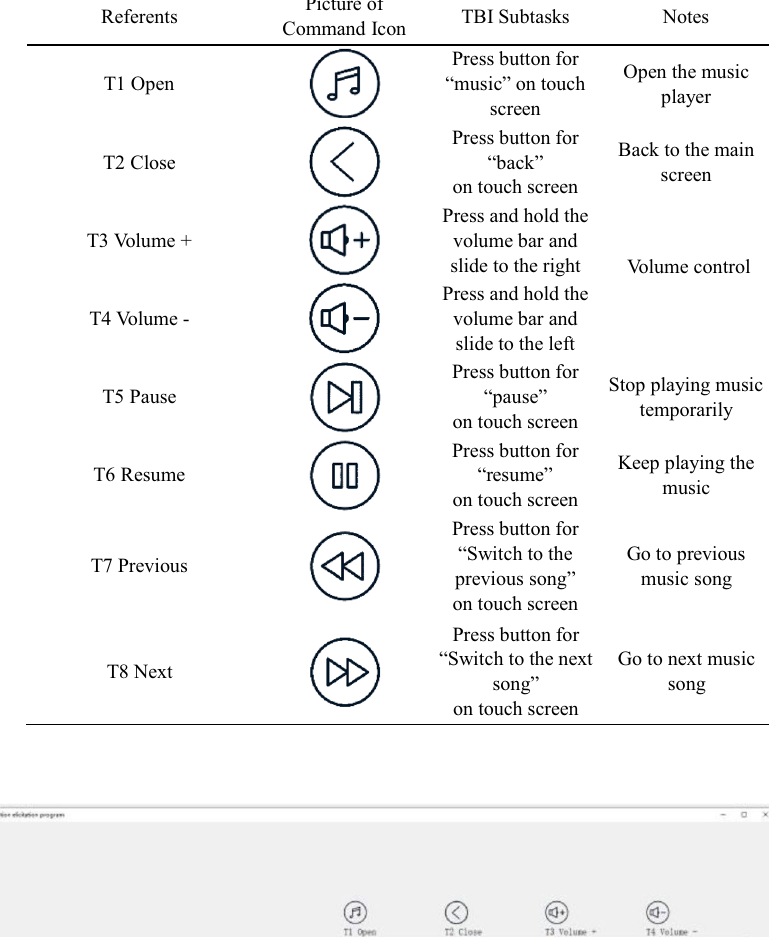
Table 4 Eight in-vehicle primary secondary tasks with